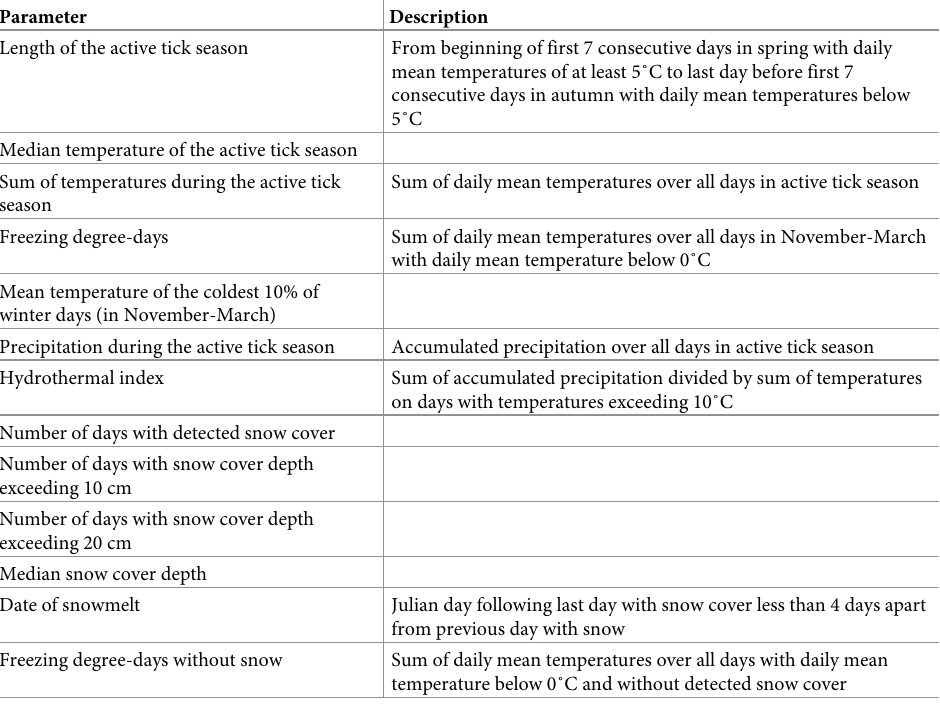
Table 1. Parameters used in linear regression analysis. The description was omitted for self-descriptive parameters. Winter parameters are calculated for the whole winter preceding the tick season with the observed borreliosis incidence